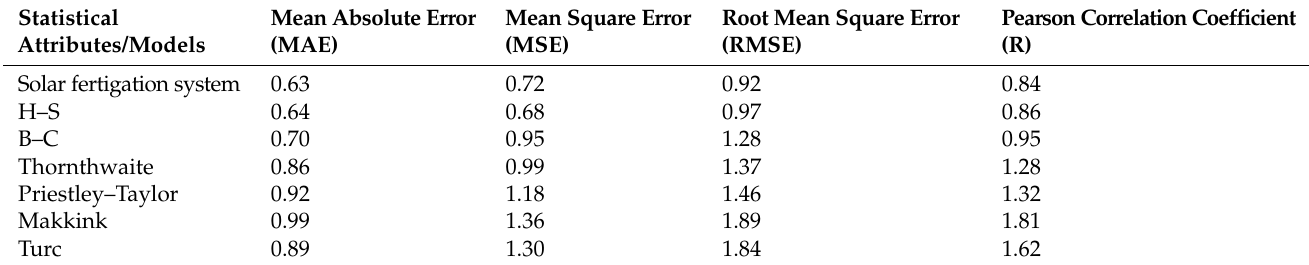
Table 4. Mean statistical attributes estimated by temperature- and radiation-based models compared with the standard combination-based FAO P–M model in Apulia region over the study period